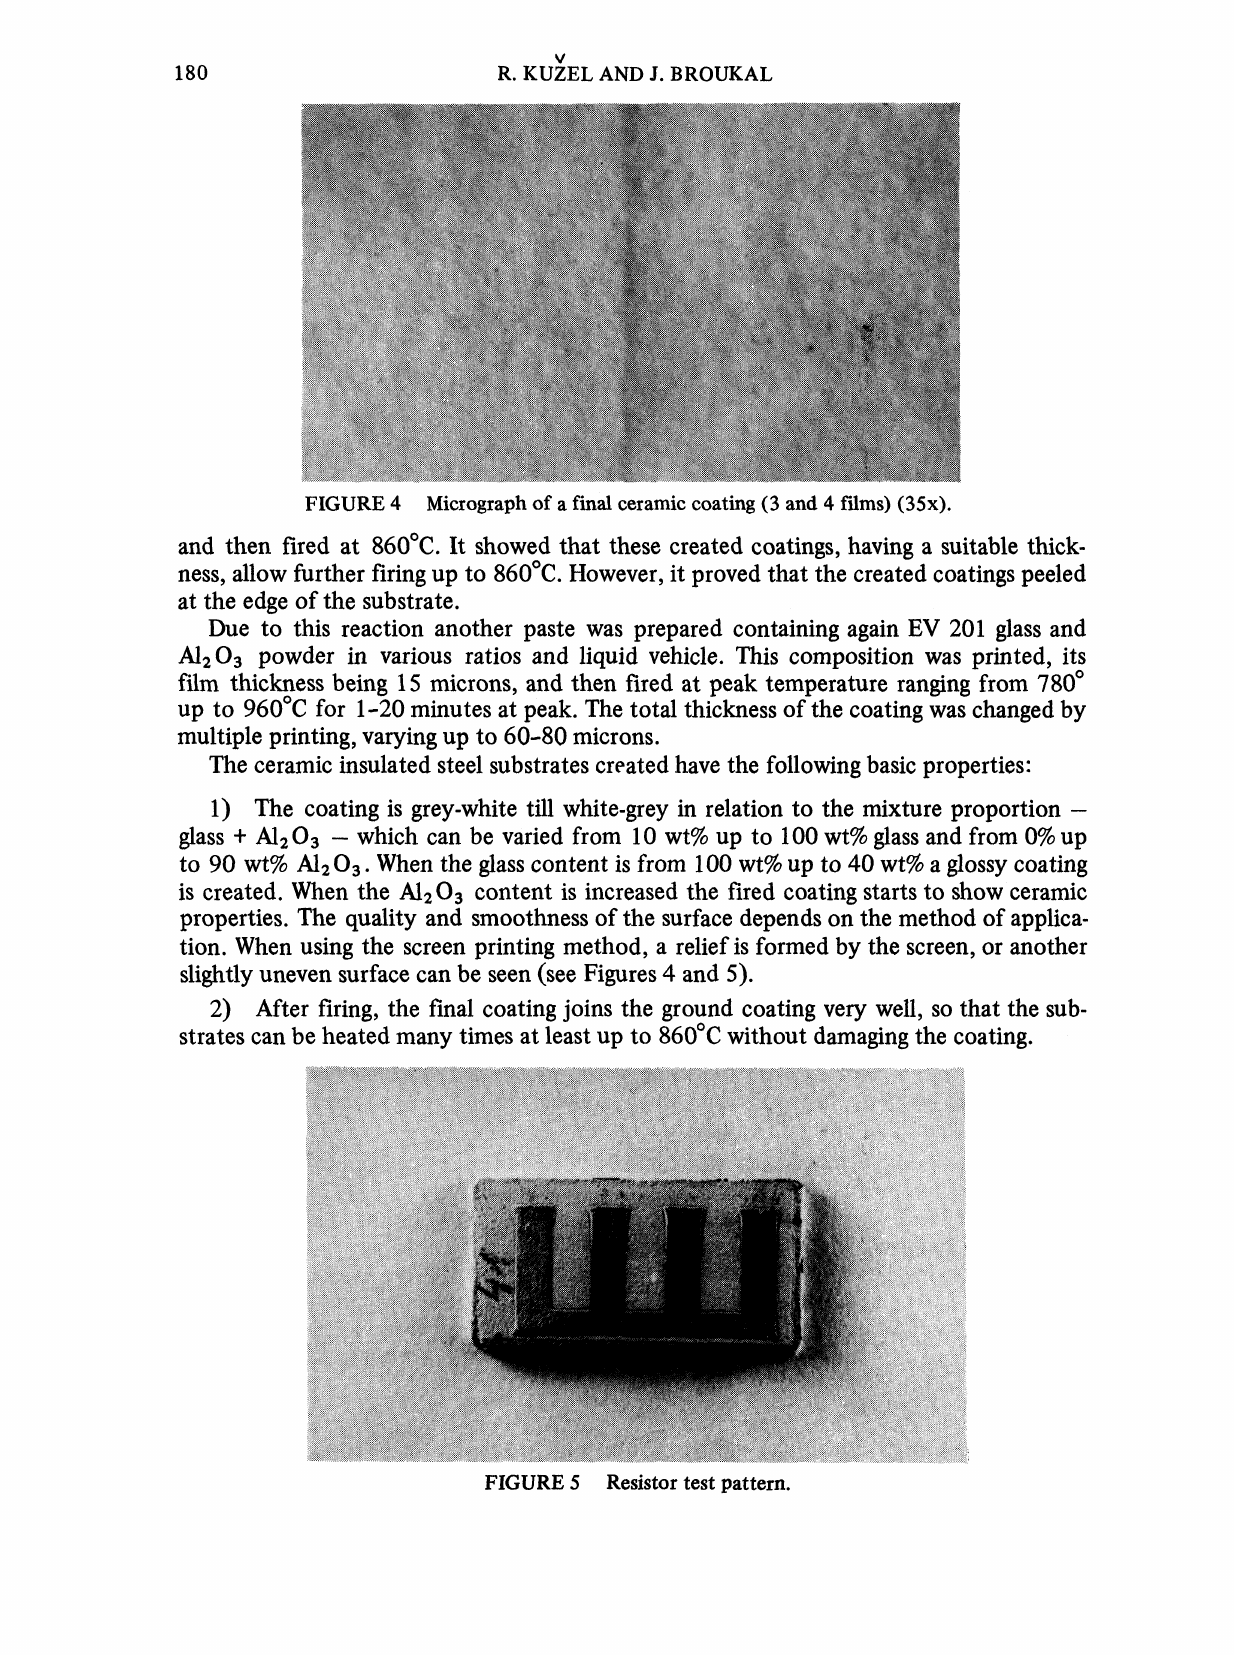
FIGURE 5 Resistor test